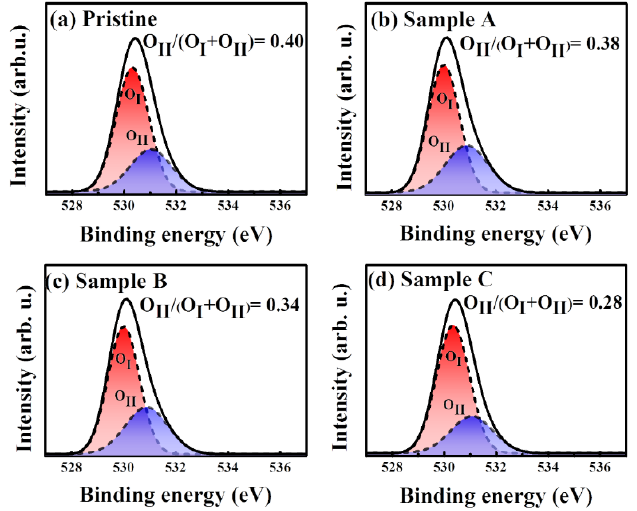
Figure 2. High-resolution O 1s XPS spectra with curve-fitting results obtained for IGZO thin films: ( a ) pristine sample and ( b ) sample A, ( c ) sample B, and ( d ) sample C.